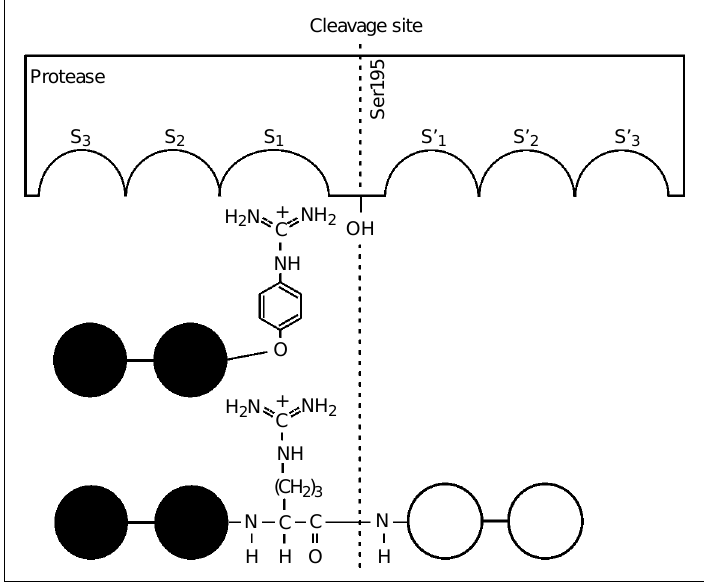
Figure 2 - Schematic comparison of the binding of a peptide-4-guanidinophenyl ester and a common peptide substrate to the active site of trypsin based on the ideas of the conventional binding model of proteases (nomenclature according to Ref.